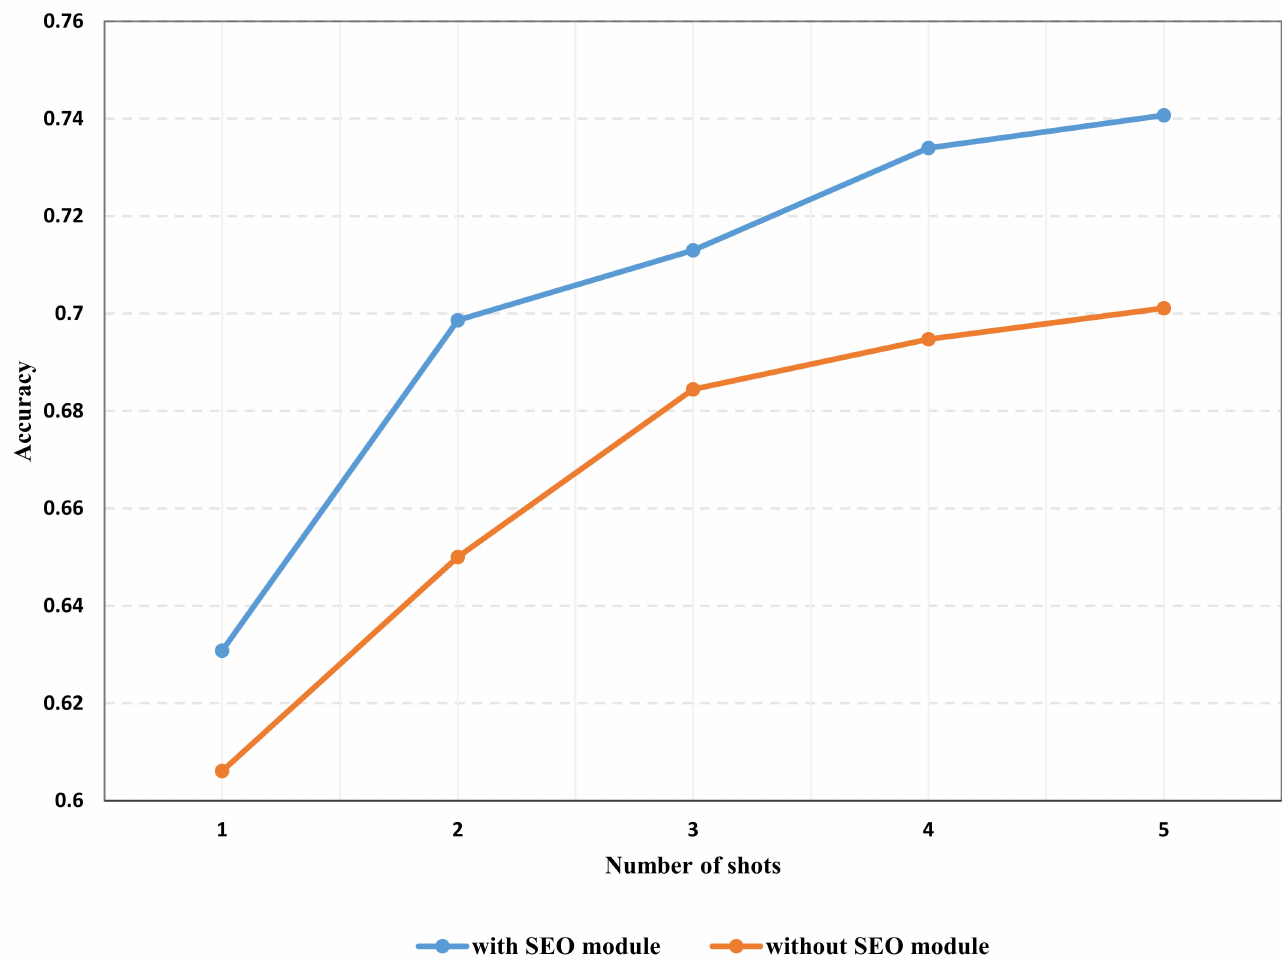
Figure 6. Results of the ablation study of the SEO module. After the SEO module is ablated, the performance of the model drops significantly in all